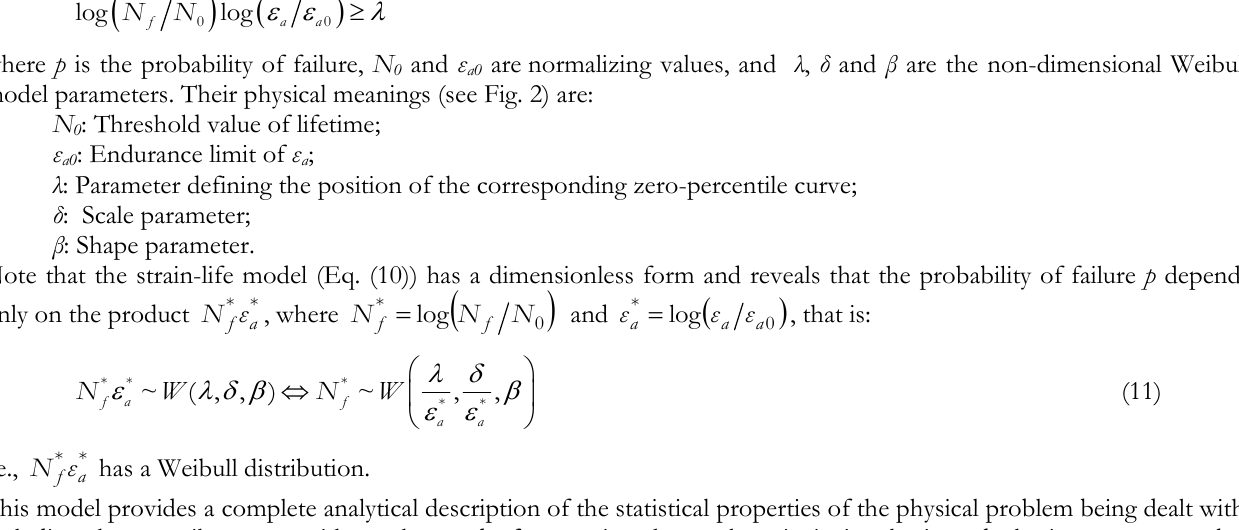
Figure 2: Percentile curves representing the relationship between dimensionless lifetime, N The SWT (= σ max . ε a ) parameter was proposed by Smith et al. [8] in order to account for mean stress effects on fatigue life prediction. Any combination of maximum stress and strain amplitude that leads to the same SWT parameter should